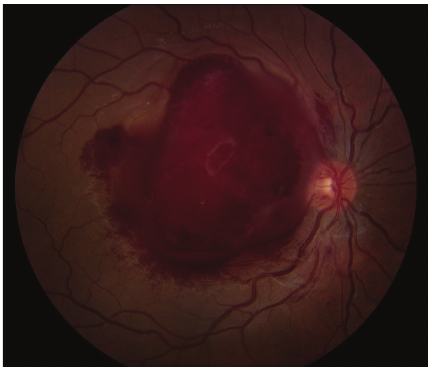
Figure 1: Color fundus photo of the right eye on the day of presentation. This shows the large preretinal hemorrhage involving almost the entire macula.